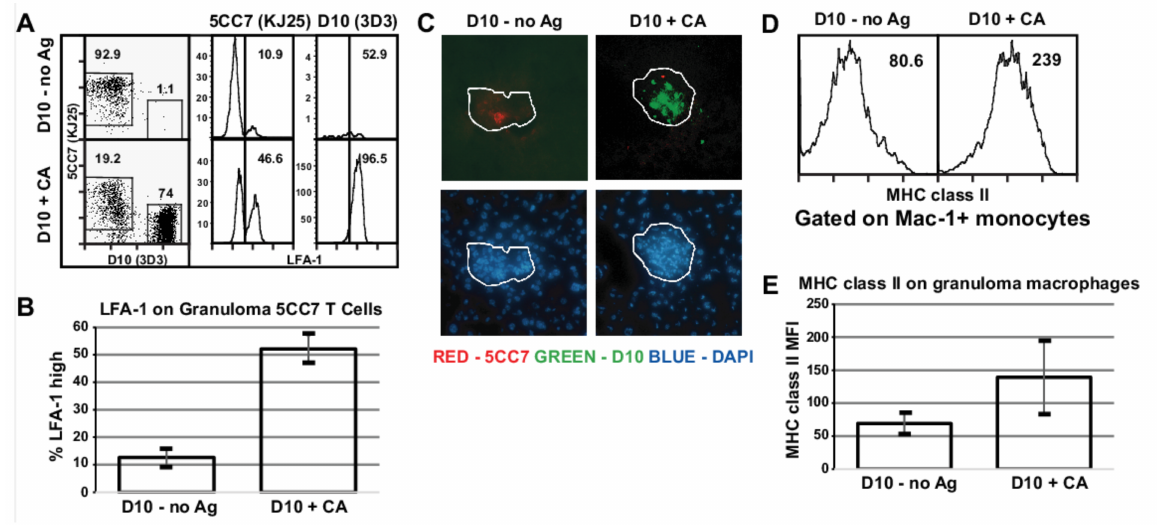
Figure 4. Acutely activated D10 T cells home to granulomas and activate granuloma-infiltrating 5CC7 T cells and macrophages. ( A ), Granuloma cells were isolated from mice treated as described in the legend to Figure 3 and stained for flow cytometry. Left plots are gated on CD4 + lymphocytes. 5CC7 (middle) and D10 (right) panels were gated as shown in the left panel and numbers represent percent LFA-1 high cells according to the gate shown. ( B ), Quantification of the percentage of LFA-1 high 5CC7 T cells. Bars represent mean and error bars represent standard deviation. ( C ), Liver tissue was embedded in O.C.T. and processed for frozen sections. Sections were stained with Alexa 488-anti-V β 8 (green, left upper panel), Alexa 568-anti-V β 3 (red, right upper panel) and DAPI (blue, lower panels) as a nuclear counterstain to outline granulomas. Fluorescent antibody stains and DAPI stains are displayed separately for clarity. White lines in panel C represent granuloma lesion outline. ( D ), Granuloma cells were stained for cell surface expression of I-A k on Mac-1 + monocytes. Numbers represent mean fluorescence intensity. ( E ), Quantification of MFI changes from panel ( D ). Bars represent mean of MFI with error bars showing standard deviation. Data representative of three independent experiments with 2–4 mice per